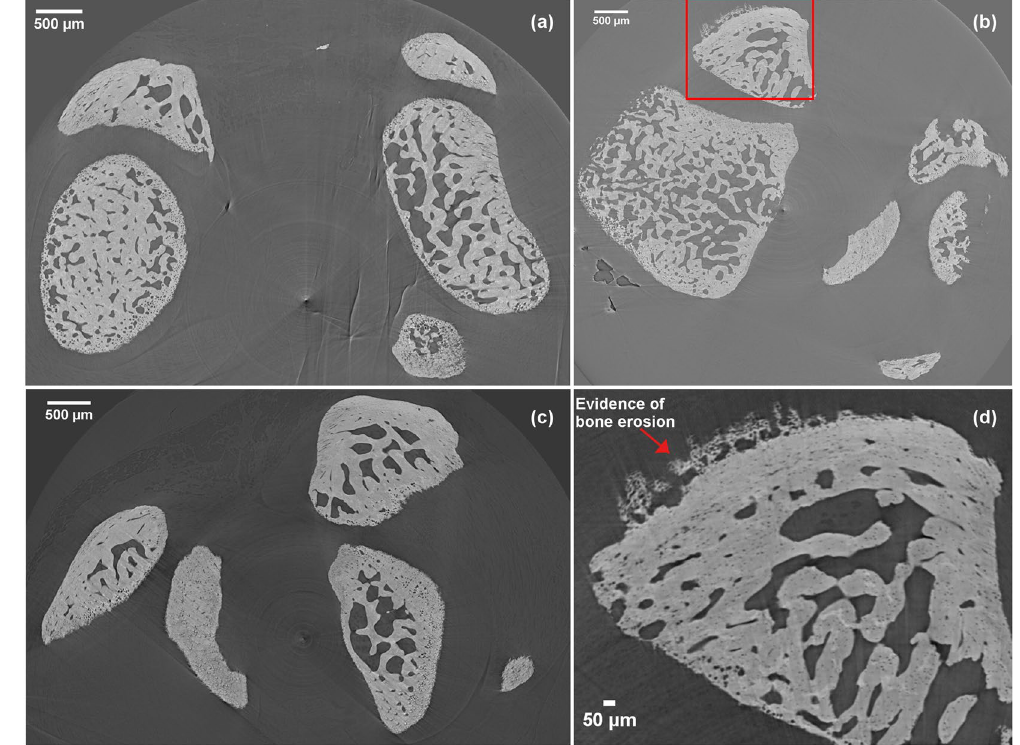
Figure 2. Comparison of representative micro-CT slices of knee joints from Antigen-Induced Arthritis (AIA) and AIA + Humira rats. ( a ) Contralateral joint; ( b ) Injected knee joint; ( c ) Injected knee joint after systemic treatment with Humira; ( d ) Enlarged detail showing bone erosion. Micro-CT slices from the injected joints showed evidence of bone erosion indicated by loss of bone density along the edge of periarticular surface (red arrow). AIA + Humira rats displayed a much smoother joint surface resembling that observed in the contralateral control